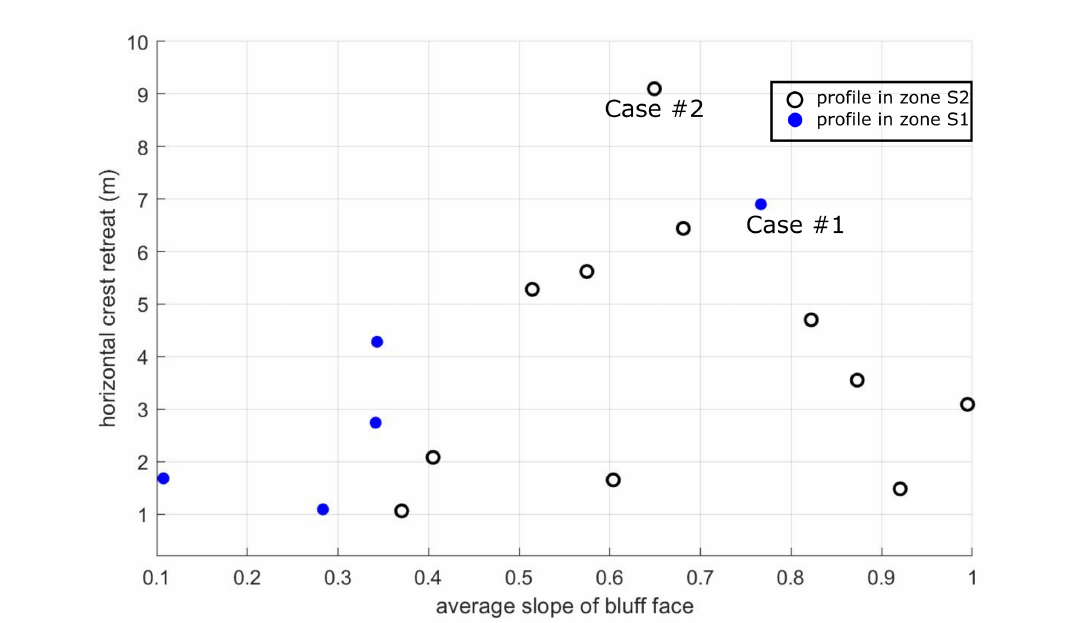
Figure 10. Thermoabrasion is the dominating erosion mechanism for the cases in the top-right zone (steeper slope and higher erosion rate). Two cases are chosen from zone S1 and zone S2 such that the crest retreat is very high compared to the other profiles and the average slope of the bluff-face is